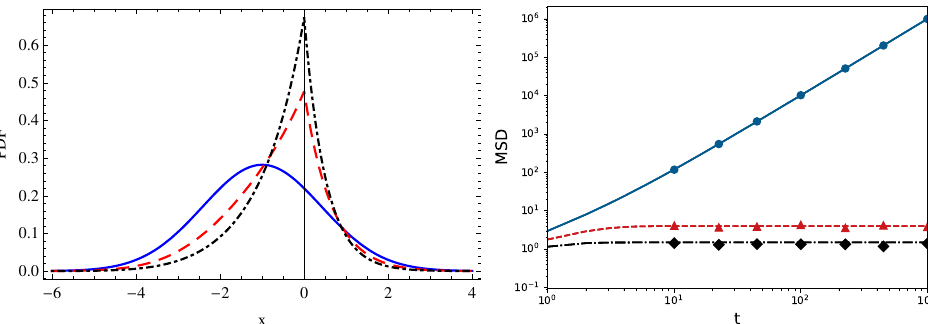
Figure 1. Left panel: Probability density function (PDF) (27) at t = 1; right panel: Mean squared displacement (MSD) (30) for D = 1, x 0 = 0, V = − 1 and r = 0 (blue solid line), r = 1 (red dashed line), and r = 2 (black dot-dashed line).